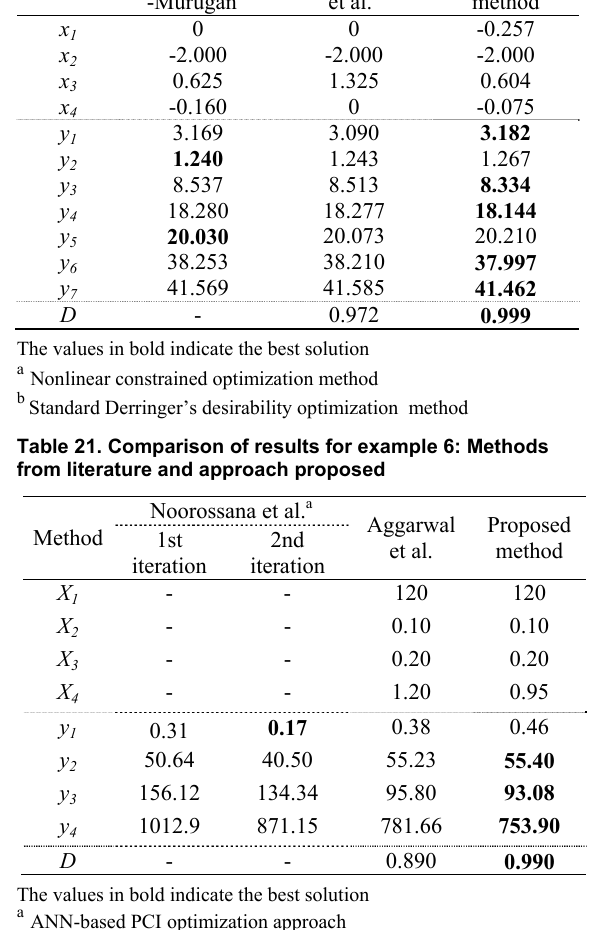
Table 20. Comparison of results for example 5: Methods from literature and approach proposed Method